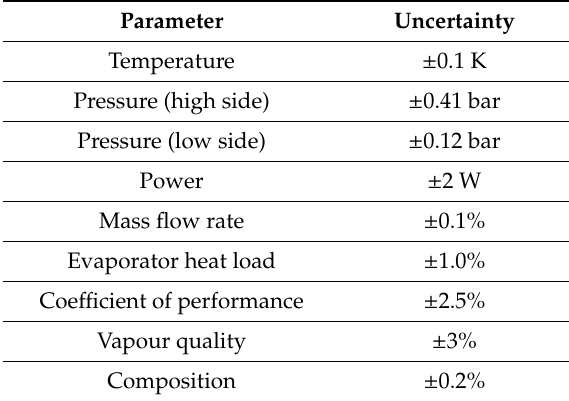
Table 1. Summary of experimental